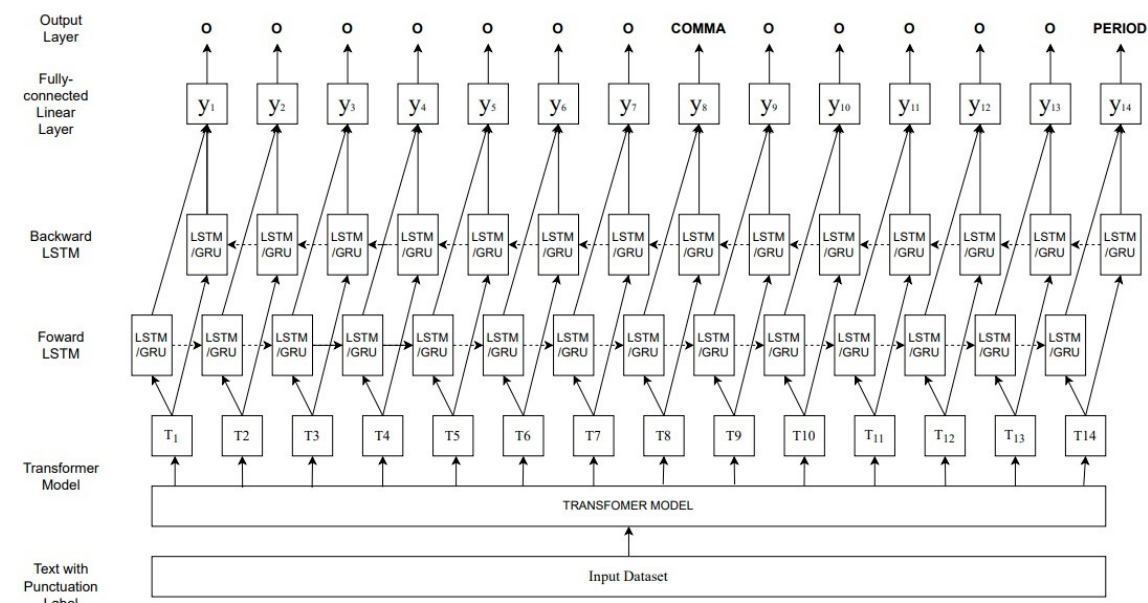
Figure 2. Punctuation-restoration-model architecture .